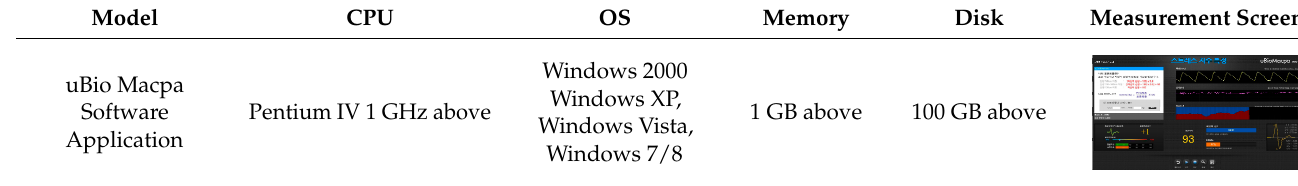
Table 9. Specifications of the software application for HRV.